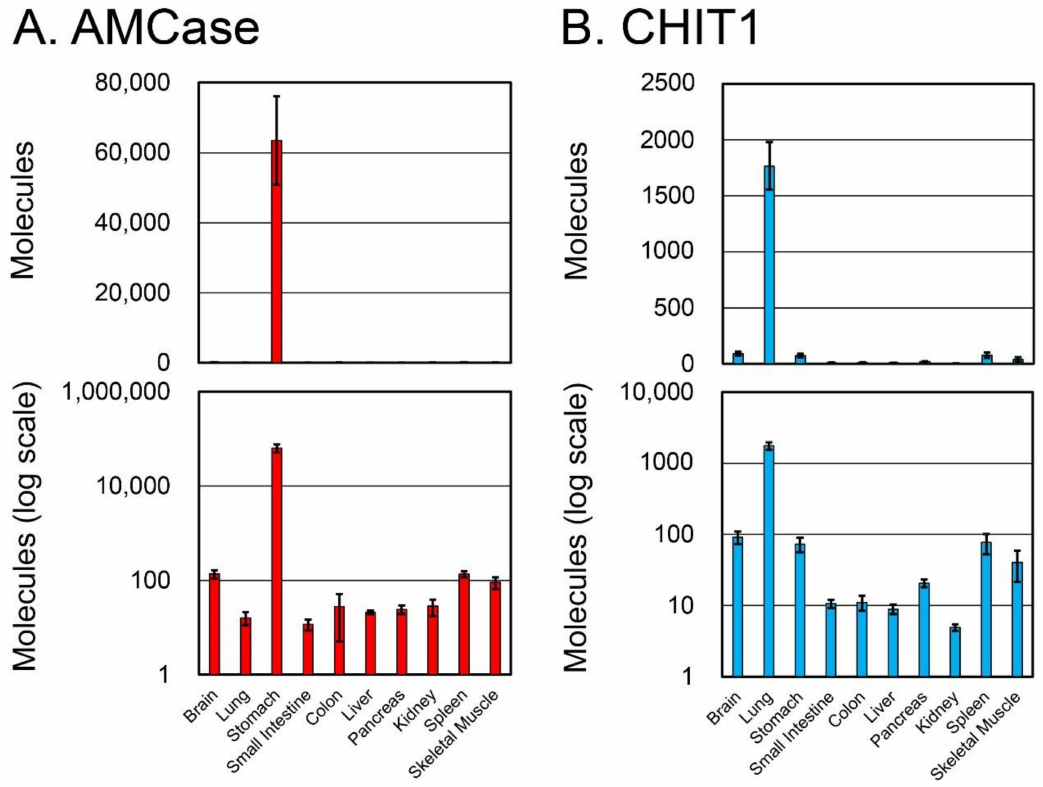
Figure 2. Expression of AMCase and CHIT1 messenger RNAs (mRNAs) in normal crab-eating monkey tissues. Quantification of ( A ) AMCase and ( B ) CHIT1 mRNA in crab-eating monkey tissues. Both chitinases were quantified by real-time PCR using the crab-eating monkey standard DNA. All values are expressed as number of molecules per 10 ng of total RNA in the y -axis. Upper panel, actual value; lower panel, logarithmic